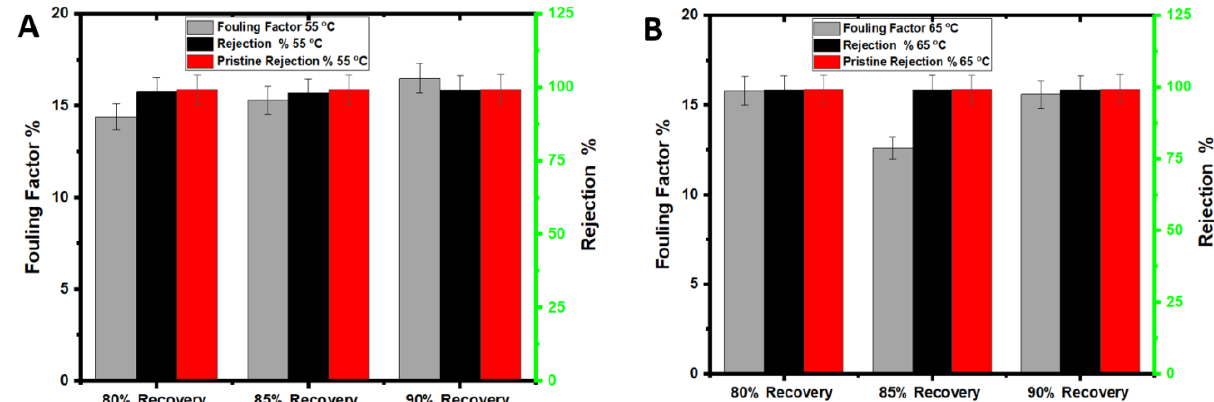
Figure 7. Fouling factor and rejection for wastewater treatment ( A ) at 55 ◦ C and ( B ) at 65 ◦ C.